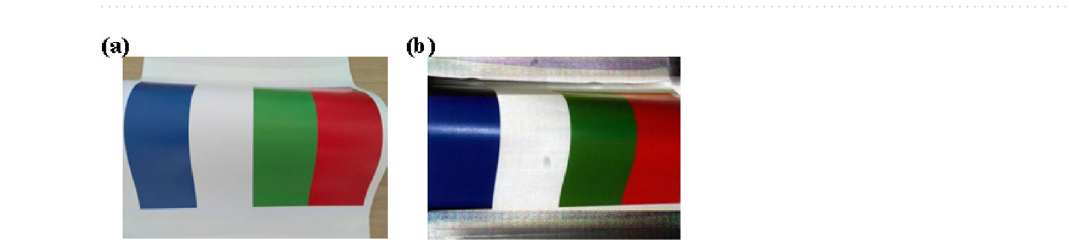
Figure 5. The color texture extraction. ( a ) The colorful object. ( b ) The extracted color